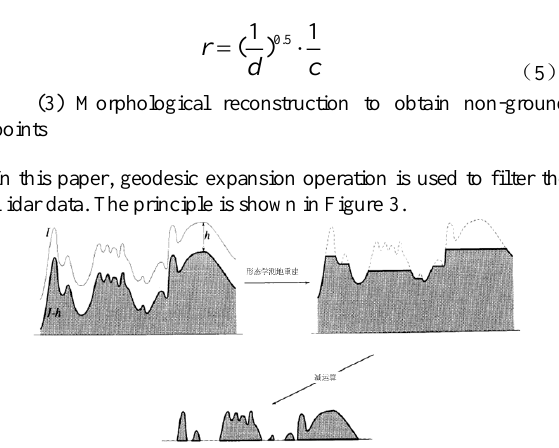
Figure 3. Figure of data filtering based on morphological reconstruction （ Cited from literature Lantuejoul C,1984